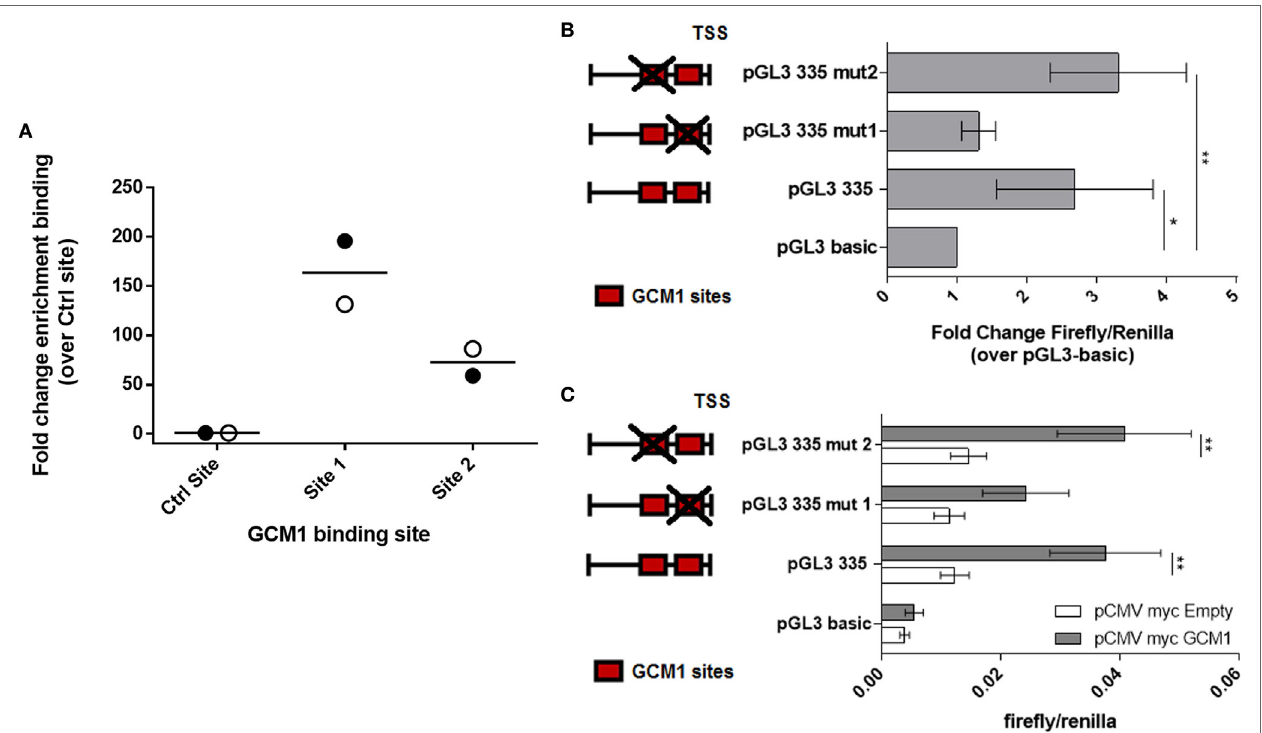
FigUre 3 | Glial cells missing 1 (GCM1) binds to the proximal LHB promoter in primary equine chorionic girdle (ChG) trophoblast cells and mutation of GCM1 site 1 results in loss of promoter activity. (a) Chromatin ImmunoPrecipitation was carried out on formaldehyde fixed chromatin complexes from passage 1 day 34 primary ChG trophoblasts, using an antihuman GCM1 antibody for immunoprecipitation. Binding of GCM1 to predicted GCM1-binding sites was expressed as fold-change enrichment over binding to a control region within the coding sequence of the LHB gene ( n = 2 conceptuses). (B,c) The two GCM1-binding sites in the pGL3-335 promoter construct were mutated. Red boxes depict GCM1 binding sites. Red box with a cross depicts a mutated site. Wild-type pGL3-335 and its two mutant constructs, pGL3-335-mut1 and pGL3-335-mut2, were co-transfected (B) into BeWo cells ( n = 3) (c) into COS7 cells, with 150 ng of pCMV-myc-GCM1 or pCMV-myc- Empty as a control ( n = 4). Promoter activity was assessed by luciferase assay. * p < 0.05, ** p < 0.01, **** p < 0.0001 [ (B) one-way ANOVA, (c) two-way